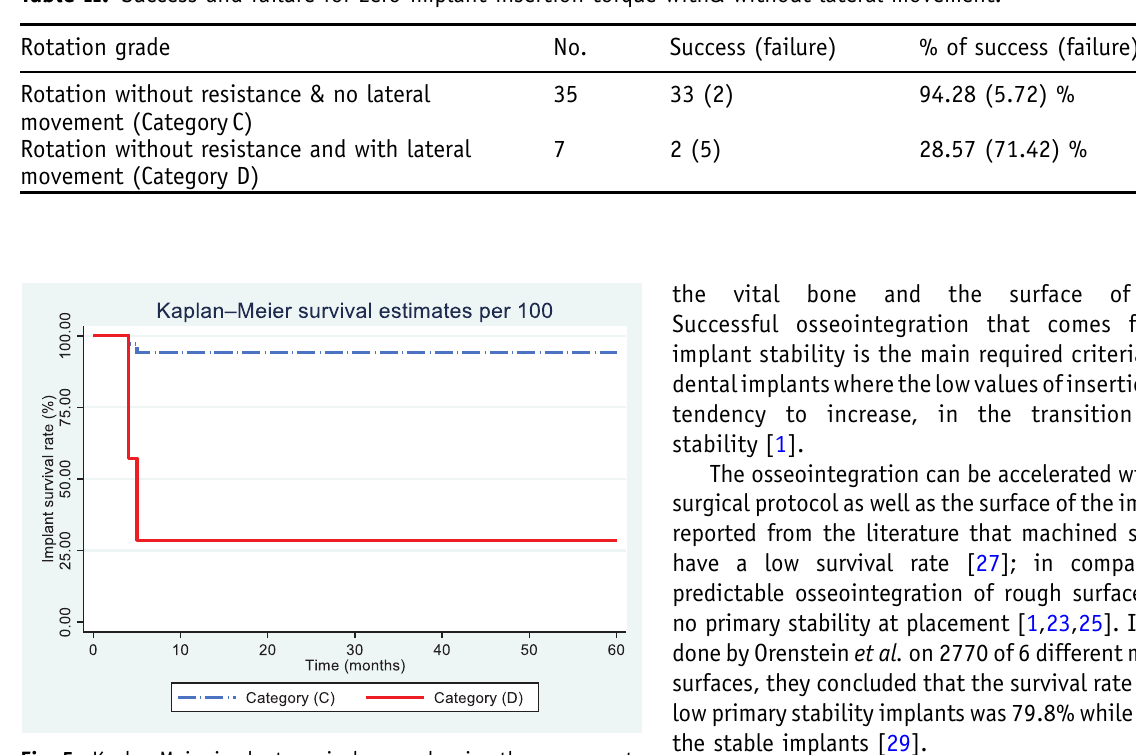
Fig. 5. Kaplan Meier implant survival curve showing the success rate for implants with zero insertion torque (category C vs. category D) for 5-years follow